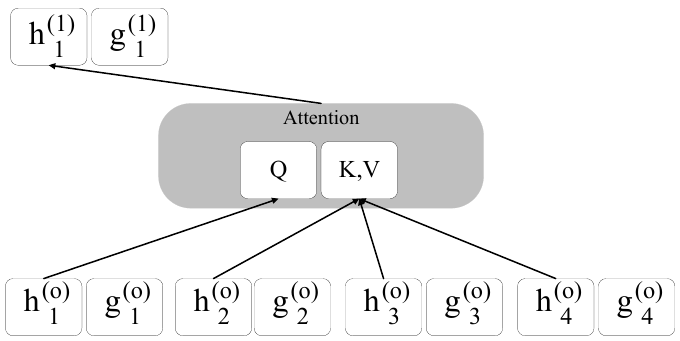
Figure 2. The architecture of two ‐ stream self ‐ attention.